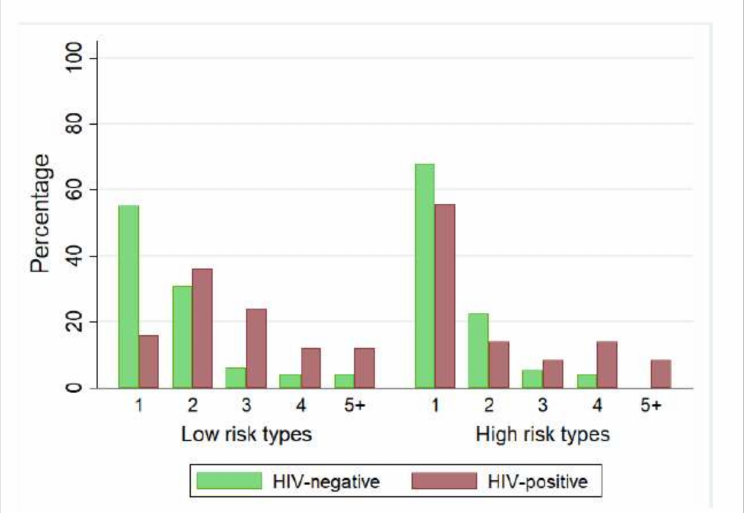
Figure 2. Percentage of women with single versus multiple types of HPV infections ( A ) and high and low risk categories HPV infections ( B ) according to HIV status.